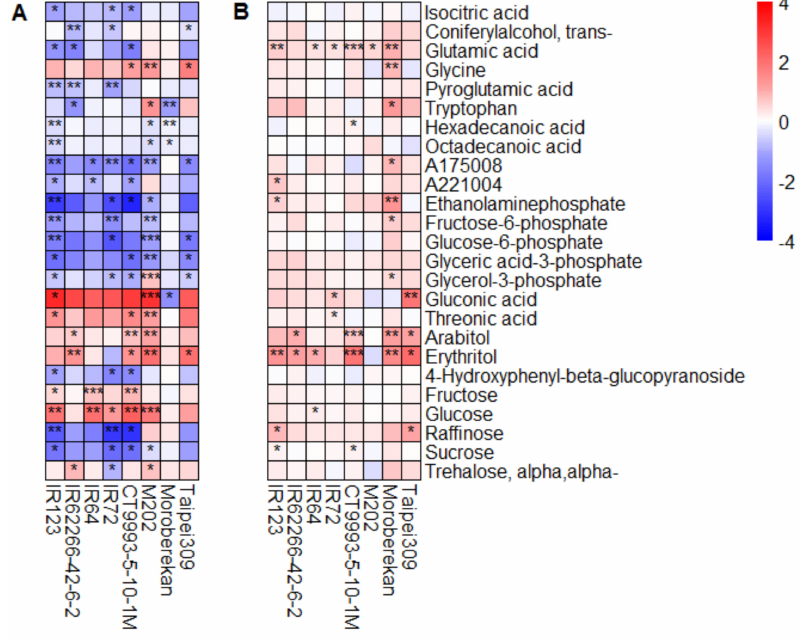
Figure A6. Log 2 fold changes in significantly changed metabolite pools under HNT compared to under control conditions in panicles for the WS ( A ). For comparison, the same metabolites are shown for the DS ( B ) independent of a significant change. For the WS ( A ), only metabolites that showed a significant change in at least three out of eight cultivars are displayed. The level of significance is indicated by asterisks (* p < 0.05; ** p < 0.01; *** p < 0.001), and the log 2 fold di ff erence is indicated by the color code. Blue indicates a lower metabolite level compared to under the control condition, and red, a higher level. Cultivars were sorted alphabetically within the respective O. sativa subspecies indica (1–4) and japonica